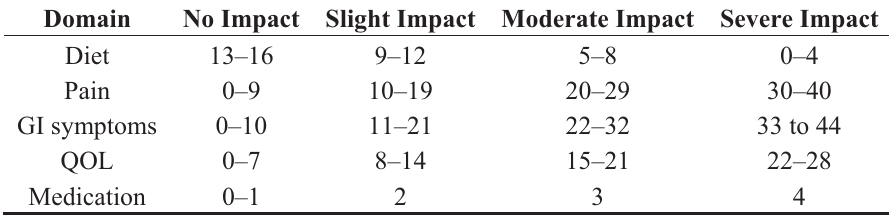
Table 6. Grouping of degree of impact on quality of life for each measured domain. The sum of the domain scores is used to determine the classification in the degree of impact on the patient’s quality of life for that domain. No impact is defined for this questionnaire as the expected values in a normal healthy